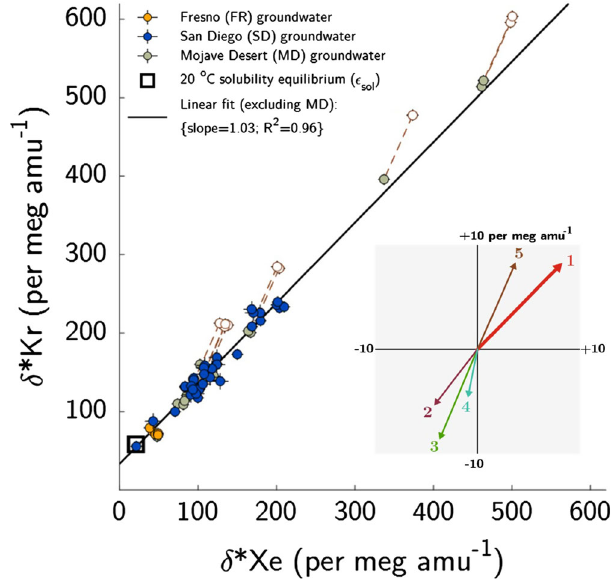
Fig. 2 Dissolved Kr and Xe isotope ratios in groundwater. Isotope ratio measurements in 58 groundwater samples collected from 36 wells illustrate the dominance of gravitational settling in driving isotopic departures from solubility equilibrium. Mojave Desert samples for which δ *Kr exceeds 200 per meg amu − 1 are shown both as original values (open circles) and corrected for fractionation due to oxygen consumption (Supplemental Note 5). Error bars indicate ±2- σ uncertainty. Inset: predicted fractionation associated with (1) two meters of gravitational settling; (2) thermal diffusion caused by a 2 °C difference between the surface and water table (WT); (3) a steady-state WT-to-atmosphere water-vapor fl ux driven by a 0.81% WT-atmosphere absolute humidity difference (equivalent to 20 °C, 65% relative humidity surface air); (4) complete dissolution of entrapped soil air bubbles (equivalent to 50% Δ Ne); and (5) steady-state oxygen depletion leading to a 0.5% atmosphere-to-deep unsaturated zone difference in the sum of O 2 and CO 2 . Note that the inset scale is magni fi